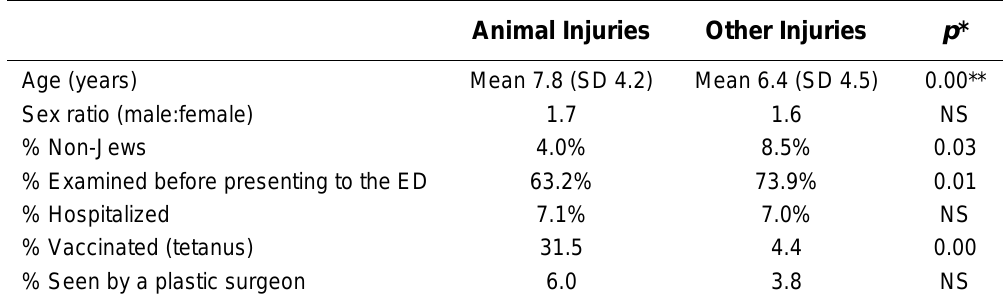
Comparing Animal Injuries with Other Injuries